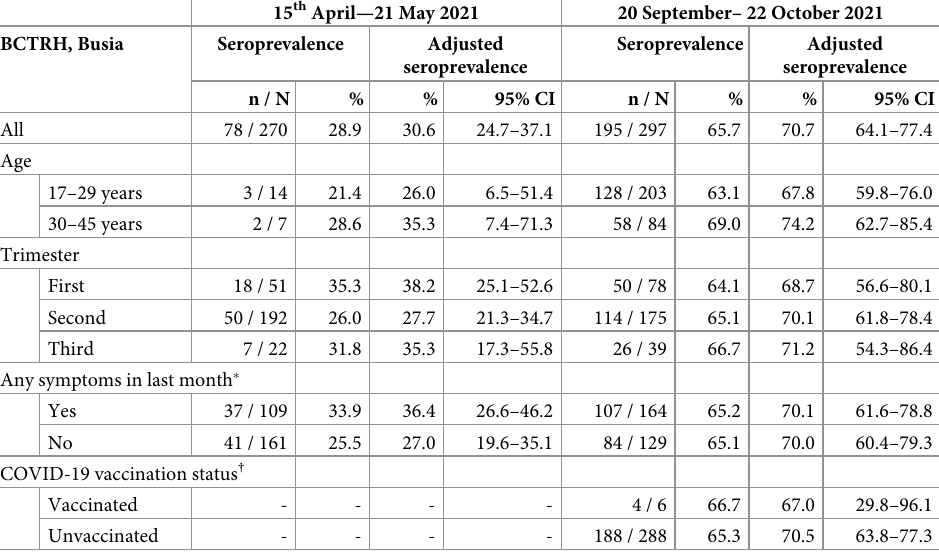
Table 2. Seroprevalence of IgG to SARS-CoV-2 among mothers attending antenatal care in Busia County Teach- ing & Referral Hospital (BCTRH), Busia.